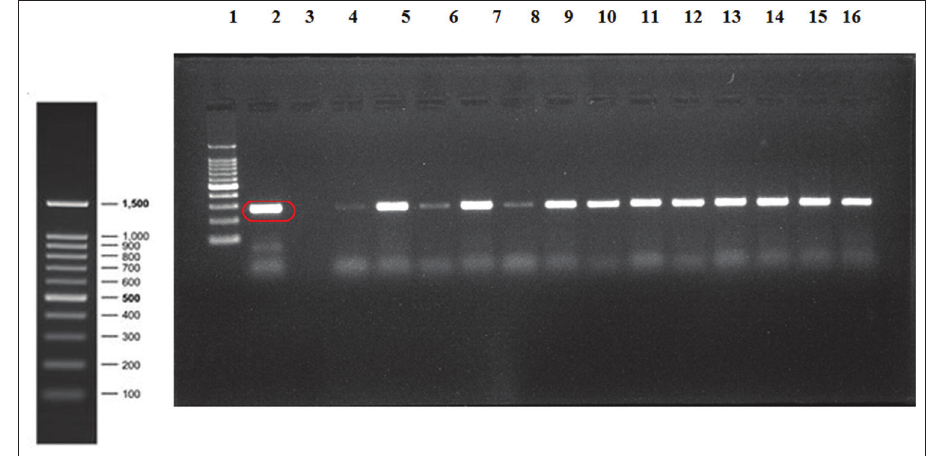
Figure-3: Fecal samples positive for ISMAP 02 primary product (278bp). Lane 1 consists of 100 bp DNA marker, lane 2 is positive standard genomic DNA, lane 3 is negative control, and lanes 4-16 consist of positive fecal samples for ISMap 02 primary polymerase chain reaction.